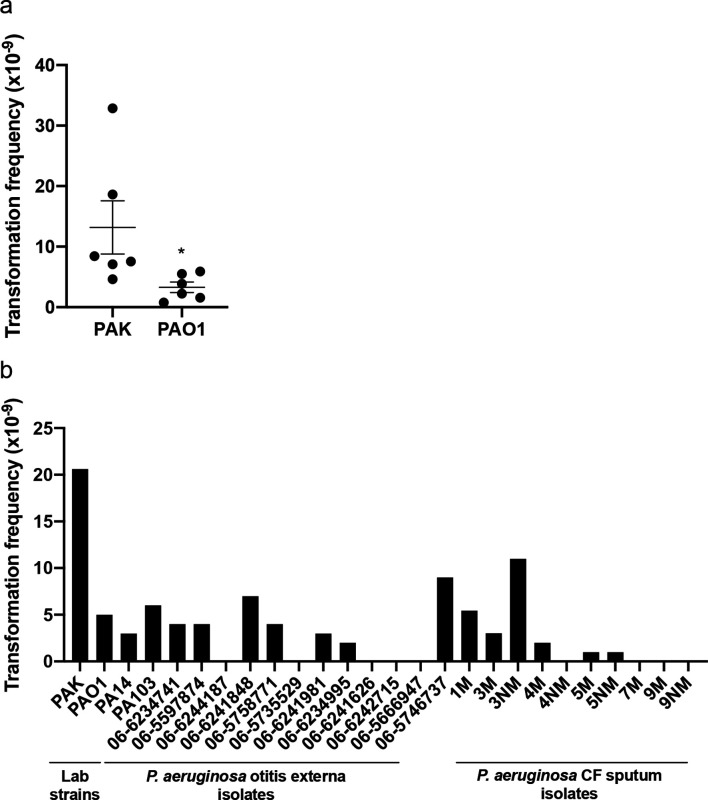
Lab and clinical strains of
P. aeruginosa
 are capable of natural transformation of plasmid DNA within colony biofilms. pUCPSK (5 µg) DNA was applied to colony biofilms of (a)
P. aeruginosa
 PAK or PAO1, or (b)
P. aeruginosa
 lab or clinical strains and incubated at 37 °C for 2 h. Cells were then harvested and the number of carbenicillin-resistant transformants determined by spread plating on selective media. For (a) the mean of each set of technical triplicates was calculated to give an n=6, which is presented as mean±sem (* P <0.05; Mann–Whitney U-test compared to PAK). For (b) the values presented are from n=1. For the CF sputum isolates the designation M refers to mucoid phenotype, NM is non-mucoid.